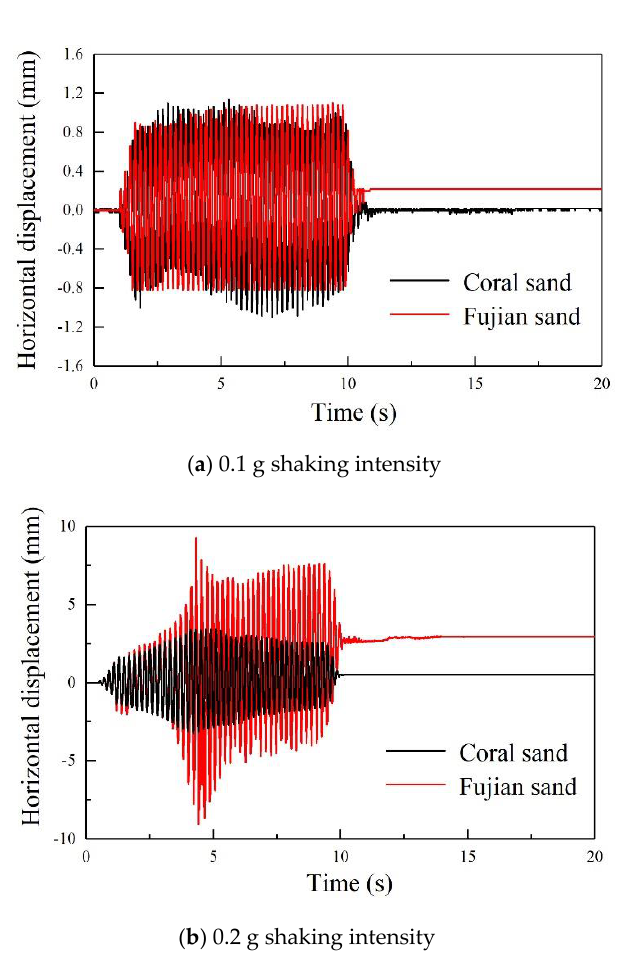
Figure 12. Horizontal displacement time history curves of building.